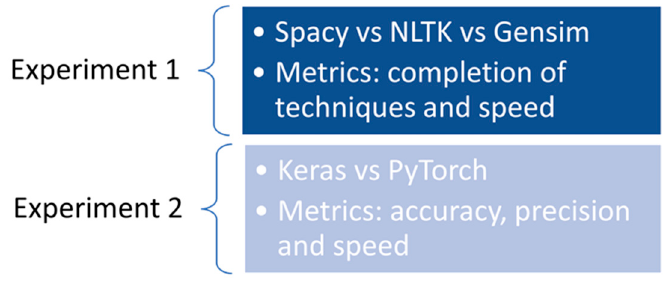
Figure 1. Experiments. Figure 1.